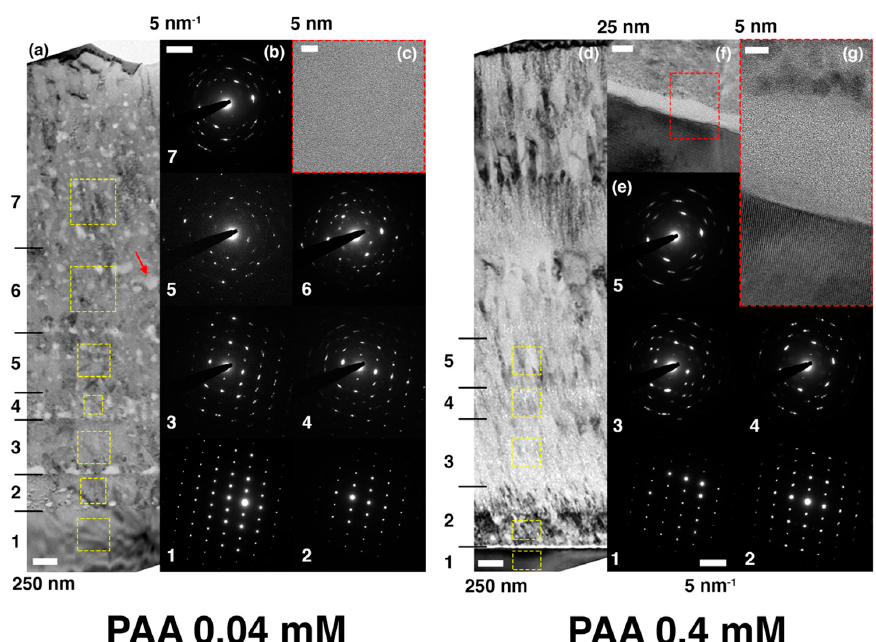
Figure 5. The microstructural and crystallographic characteristics of the coatings grown with ( a – c ) 0.04 mM and ( d – g ) 0.4 mM of PAA, respectively. ( a ) The bright-field TEM image showing the entire coating cross section of the sample with 0.04 mM of PAA and ( b ) corresponding selected area electron di ff raction patterns obtained in the area within each dotted yellow box in ( a ). ( c ) The high-resolution TEM image taken on the brightly-contrasted spot indicated by the red arrow in ( a ). ( d ) The bright-field TEM image showing the entire coating cross section of the sample with 0.4 mM of PAA and ( e ) corresponding selected area electron di ff raction patterns obtained in the area within each dotted yellow box in ( d ). ( f ) The bright-field TEM image showing the interfacial region between the substrate and coating. ( g ) The high-resolution TEM image magnifying the region within the red dotted box in ( f ). In order to investigate the epitaxial relationship of the coated layer, the electron di ff raction patterns in ( b ) and ( e ) were obtained without adjusting the specimen tilting angles once they are fixed along the zone axis of the substrate.